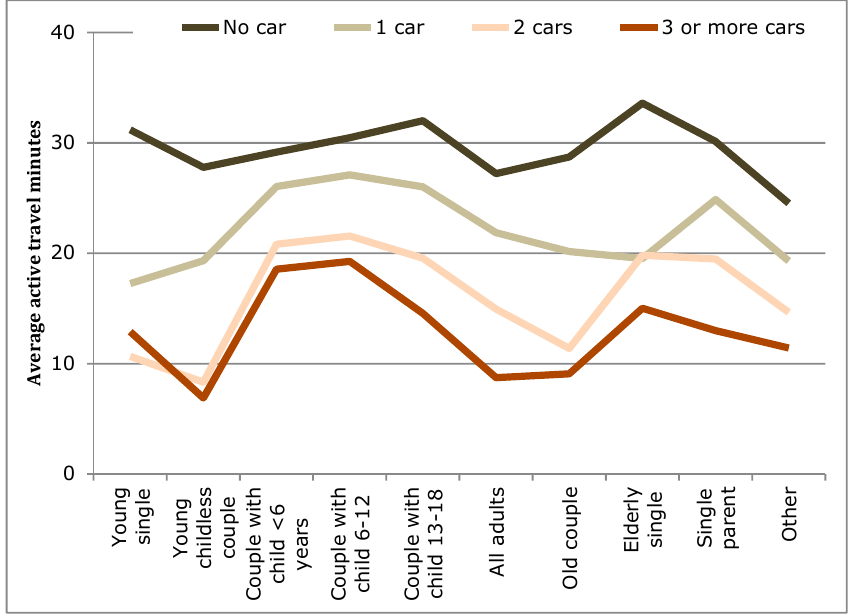
Figure 9. Changes in average active transport time per person for car ownership by lifecycle stage.